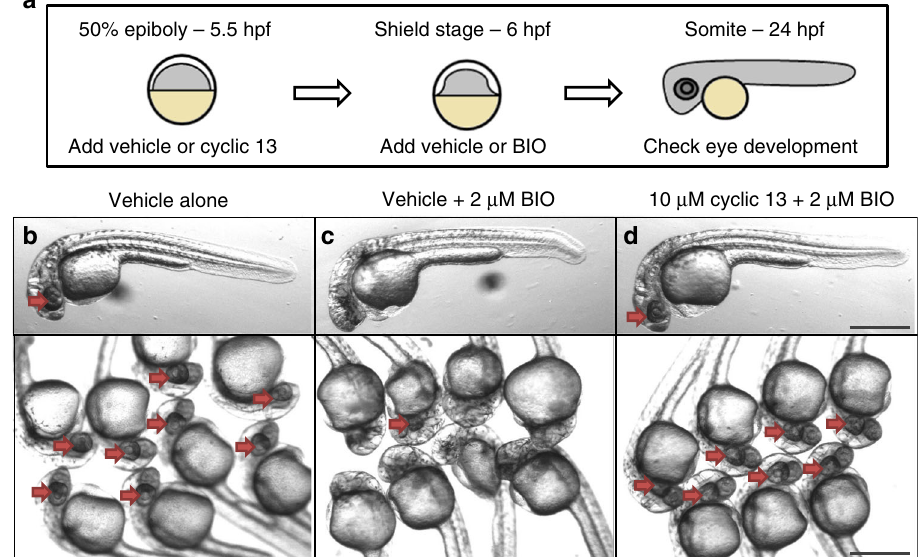
Fig. 6 Zebra fi sh phenotypic assay of Wnt signaling. a Schematic for experimental design. b – d Images of 24 h post-fertilization of zebra fi sh embryos treated with vehicle alone ( b ), vehicle plus BIO to activate Wnt signaling ( c ), or macrocycle 13 in combination with BIO ( d ). Red arrows point to developing eye structures. Scale bar represents 500 μ